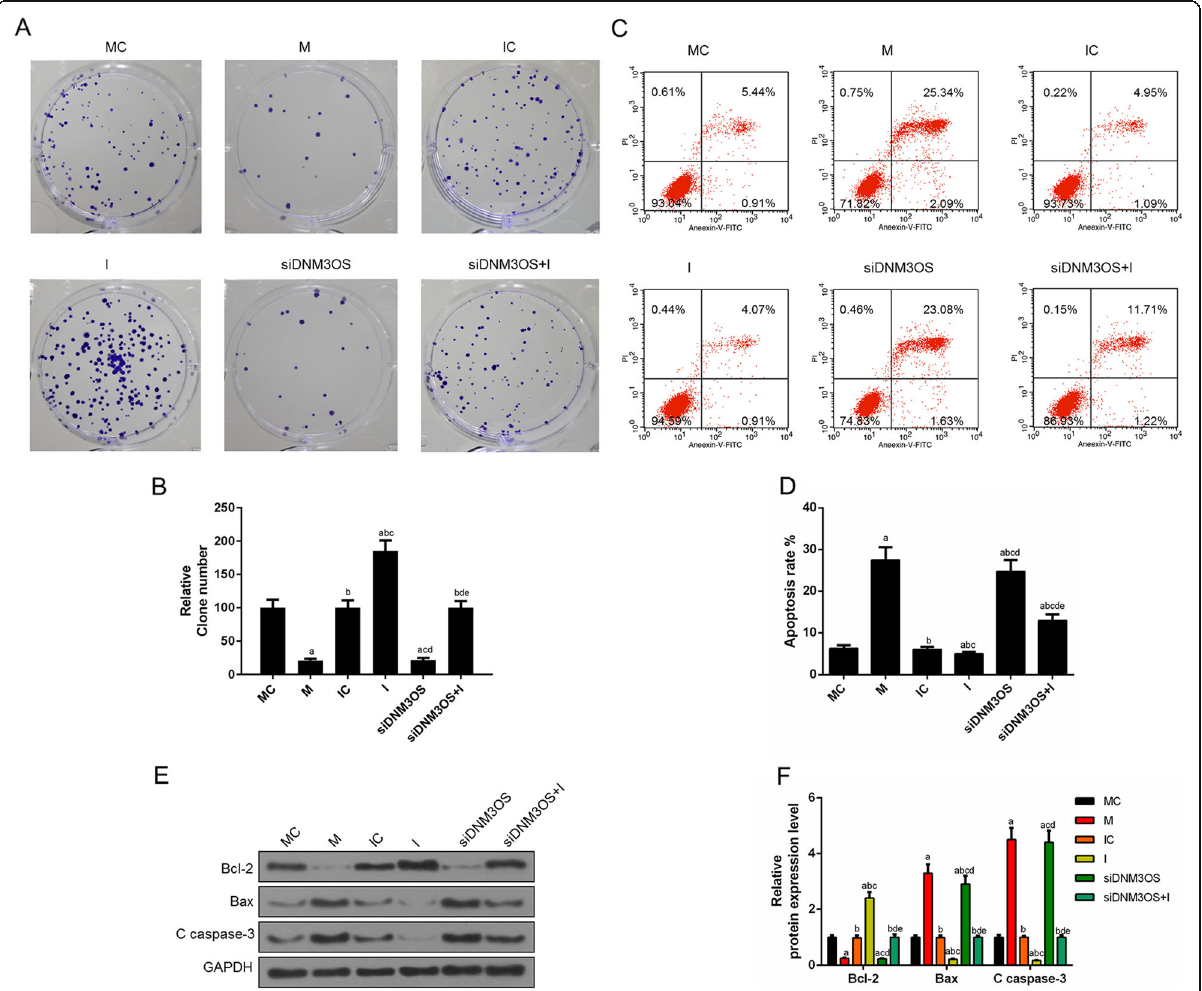
Fig. 5 The down-regulation of miR-126 abolished the DNM3OS knockdown-mediated inhibition of cells proliferation and promotion of cell apoptosis. ( a ) Co-transfecting si-DNM3OS and miR-126 inhibitor promoted cell proliferation as shown by cloning formation experiment. ( b ) The number of proliferated cells was quantified. ( c ) Cells apoptosis was triggered by silencing DNM3OS, which partially reversed by miR-126 inhibitor. ( d ) The proportion of apoptosis was quantified. ( e ) The apoptosis-related proteins (Bcl-2, Bax and c caspase 3) were detected by Western blot. ( f ) The relative levels of proteins described in ( e ) were counted by GAPDH as normalization. a P < 0.05 vs. MC, b P < 0.05 vs. M, c P < 0.05 vs. IC, d P < 0.05 vs. I, e P < 0.05 vs. siDNM3OS. M: miR-126 mimic; I: miR-126 inhibitor; MC: miR-126 mimic control; IC: miR-126 inhibitor control; siDNM3OS: small interfering dynamin 3 opposite strand; Bcl-2: B-cell lymphoma-2; Bax: Bcl2-associated X